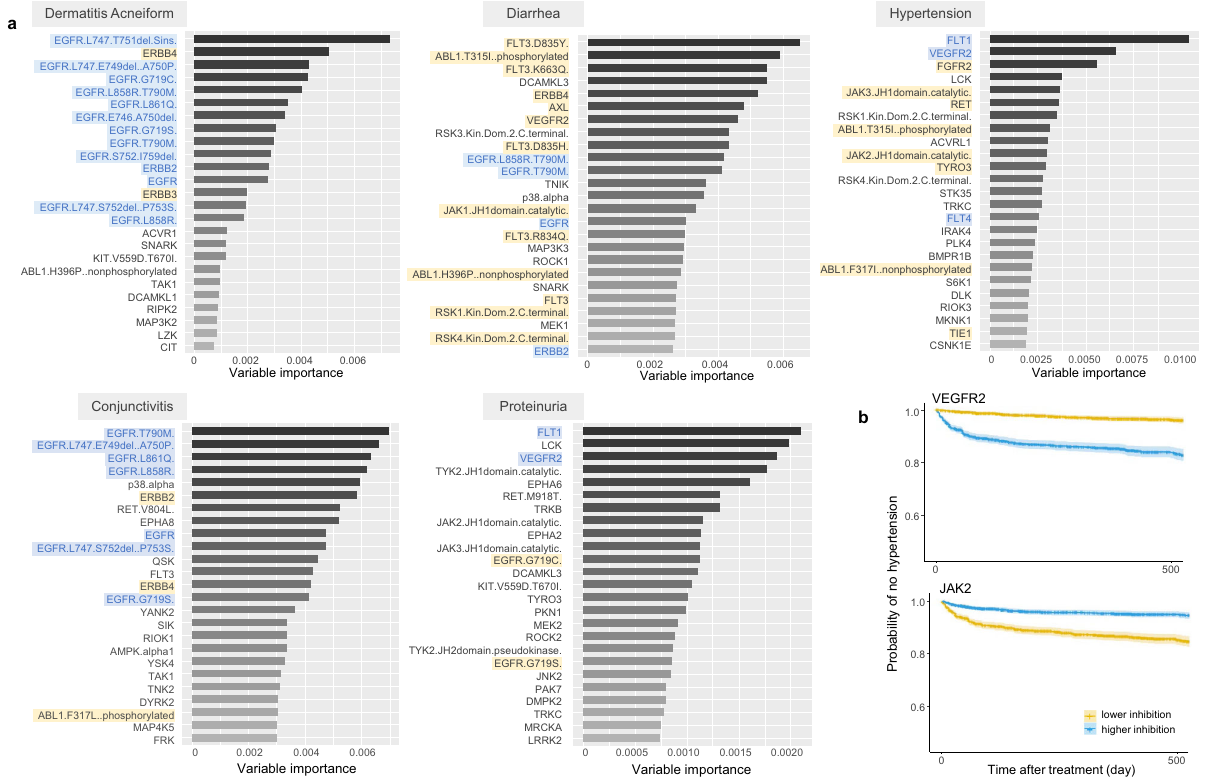
Fig. 2 | Potential association between kinase and AE as identi fi ed by ML mod- eling. a Variable importance (VIMP) assessment of n =444 predictive variables for fi ve representative AEs. Bar length indicates the VIMP value of the variable, which represents the difference in the out-of-bag model prediction errors with and without this predictive variable being permuted 43 . The identi fi ed top 25 predictive variablesarelistedforeachAE.Theblue-highlightedkinasesaretherepresentative experimentally well-established KI – AE pairs 6 . The yellow-highlighted pairs are